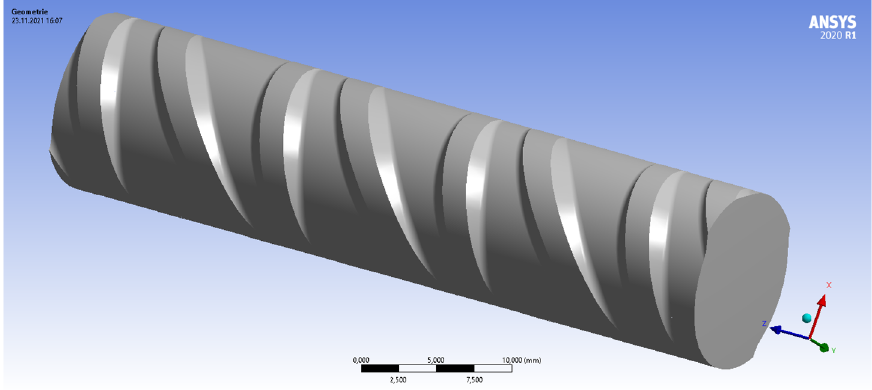
Figure 2. Geometry of a specimen with a diameter of 12 mm used for FEM .